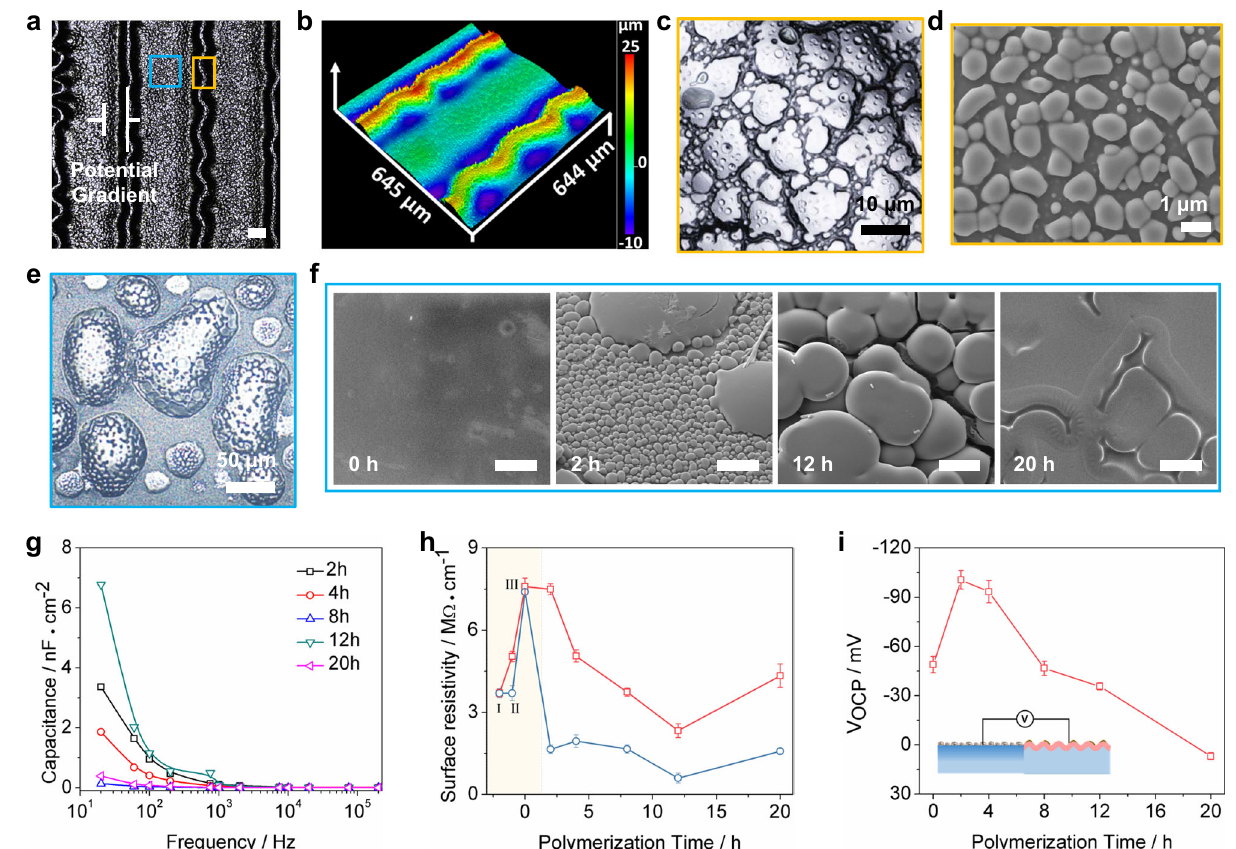
Fig.6|Regulationofthepotentiometricgradient.a Microscopyimageoftheas- prepared stripedHAIM; the blue and yellow frames represent the IL-dopedPEDOT @primary patterns and raw PEDOT @ secondary wrinkles, respectively. b LSCM images of the HAIM stripes corresponding to a . c Microscopy images and d SEM images of raw PEDOT on secondary wrinkles. e Microscopy images of as-prepared IL-doped PEDOT after polymerization for12 h. f SEM images of IL-doped PEDOT with different polymerization times, scale bar: 5 μ m. g Interfacial capacitance changes of as-prepared striped HAIM with different polymerization times and frequencies. h Surface resistivity of as-prepared HAIM stripes (red line and gray-